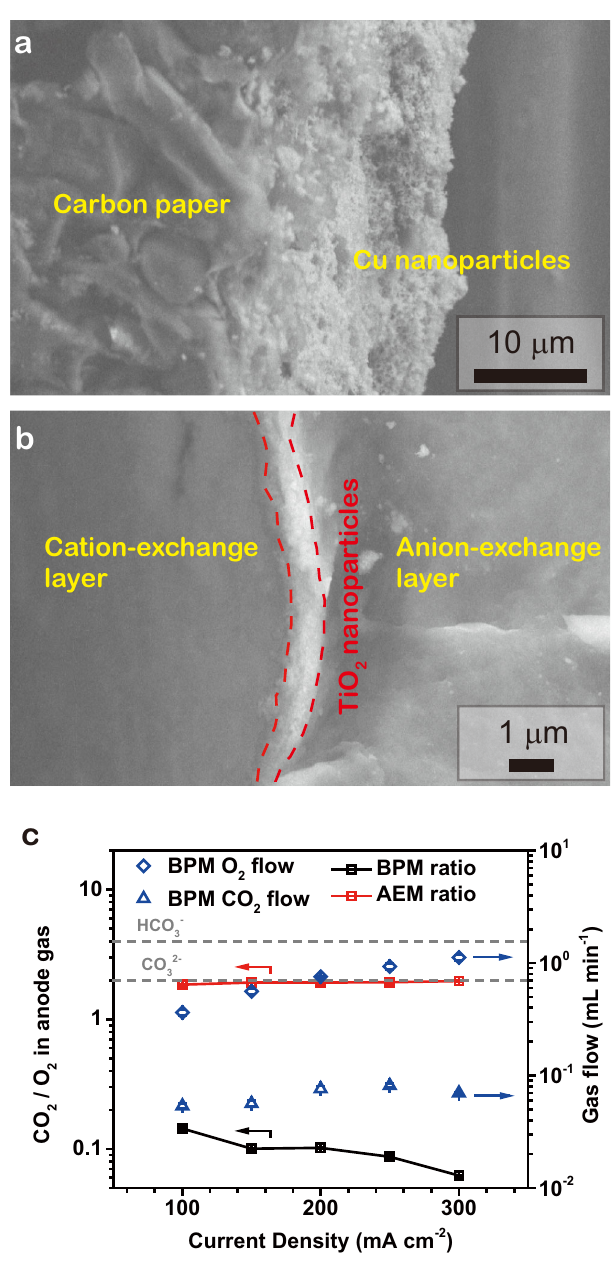
Fig. 2 Characterization of electrodes and BPM. Scanning electron microscopy (SEM) images of the cathode electrode ( a ) and the CEL/AEL interface of the custom BPM used for SC-BPMEA in neutral 0.1 M KHCO 3 anolyte ( b ). The custom BPM consists of a Na fi on TM 212 as CEL, Piperion (Versogen) as AEL, and a TiO 2 nanoparticle layer sandwiched in between as the water dissociation catalyst. c The CO 2 /O 2 ratio in the anode gas stream for the conventional electrolyzers (red squares) and our SC-BPMEA (black squares) at various current densities. O 2 and CO 2 fl ow rates in the SC-BPMEA are also indicated. The plots show data obtained after 1 h of continuous electrolysis at each current density. The data are from an SC- BPMEA with a 125 μ m-thick SC-layer. Similar data were collected for 65 and 250 μ m layers (difference below 5%). The error bars represent the standard deviation of three and SI5). We selected 250, 125, 65, and 16 μ m as the modelled